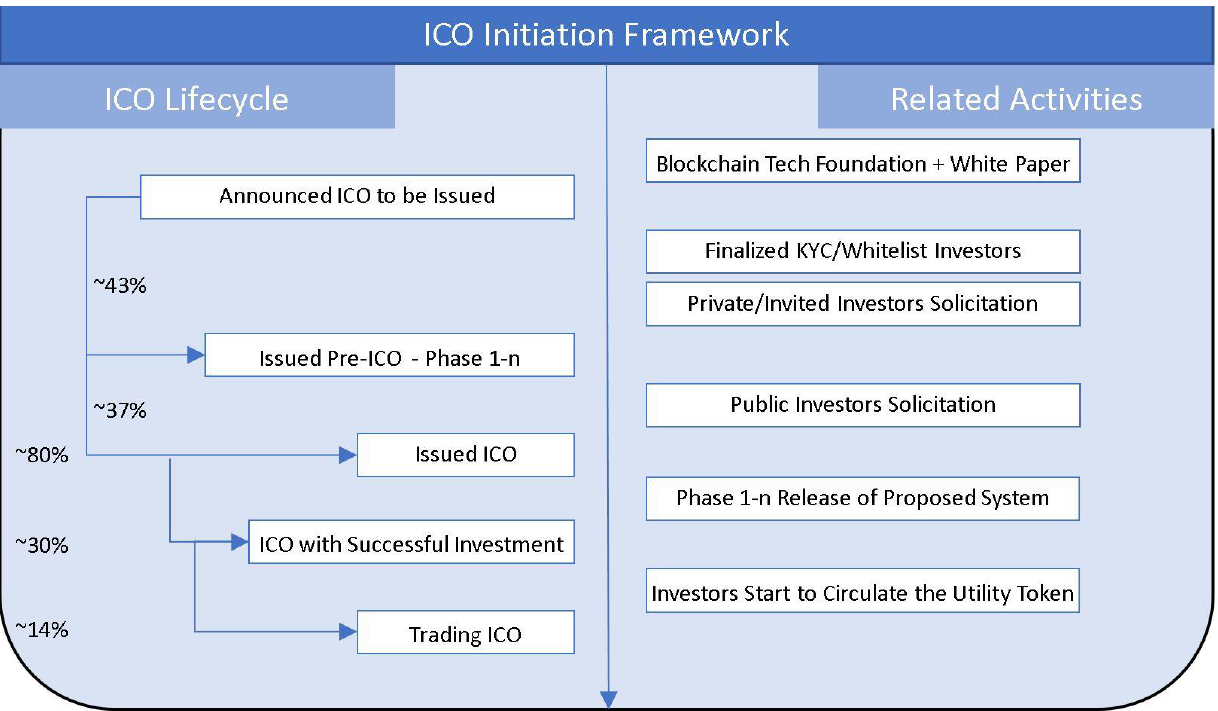
Figure 2. ICO overview of the marketplace. Source: From the verified dataset retrieved from ICO- Bench.com.